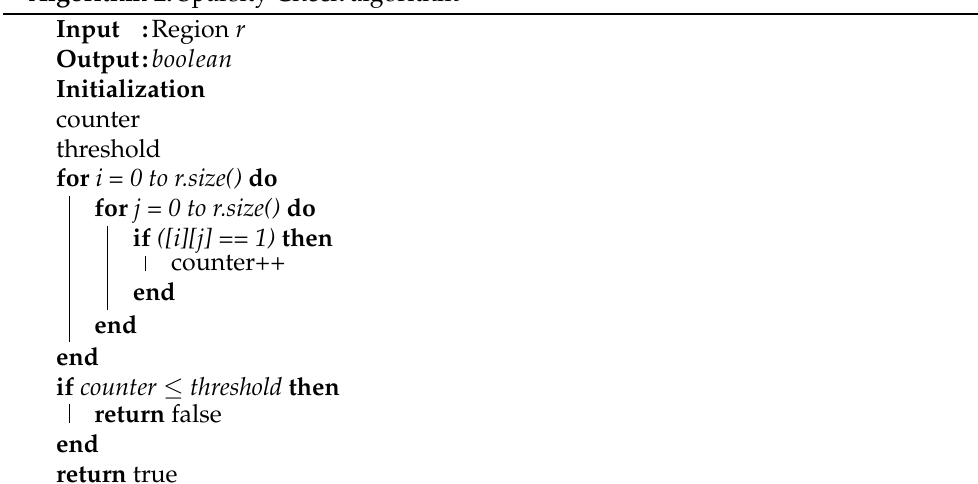
Algorithm 2: Sparsity Check